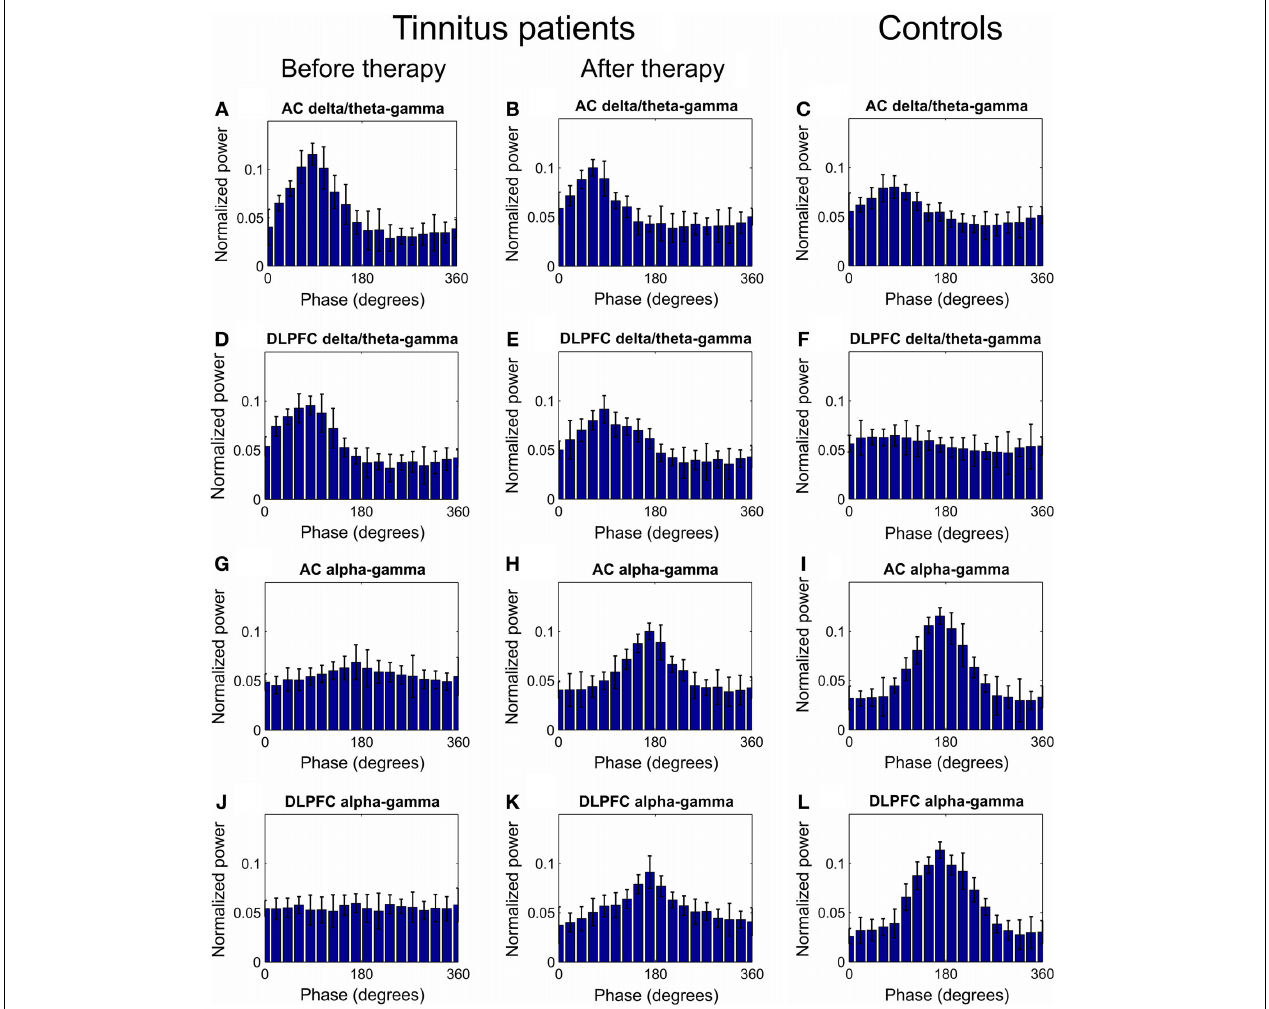
FIGURE 1 | Grand average of the distribution of gamma power across all delta/theta and alpha phases. (A–C) Distribution of AC gamma power across delta/theta phases at baseline (A) and at 12 weeks visit (B) in tinnitus patients and in tinnitus free controls (C) . (D–F) Distribution of DLPFC gamma power across all delta/theta phases at baseline (D) and at 12 weeks visit (E)